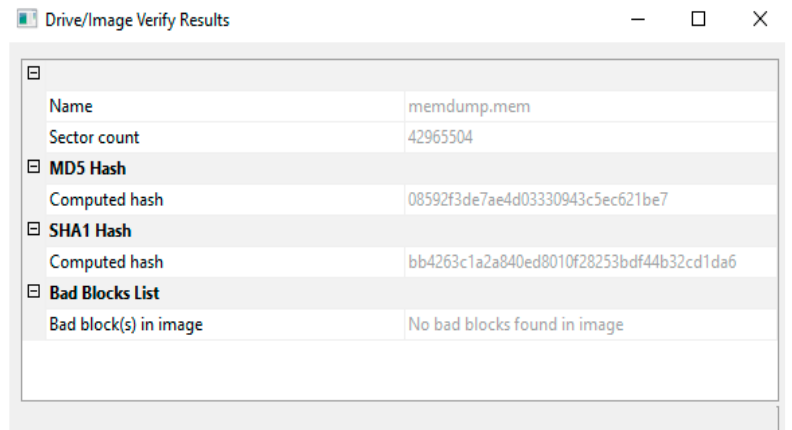
16 of 20 Figure 12. Capturing volatile and nonvolatile data.